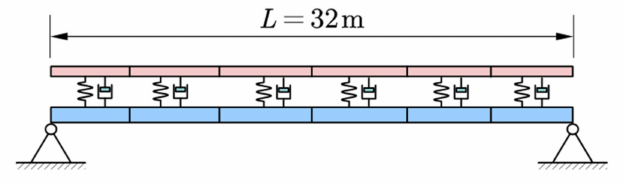
Figure 3. The double − beam finite element model.